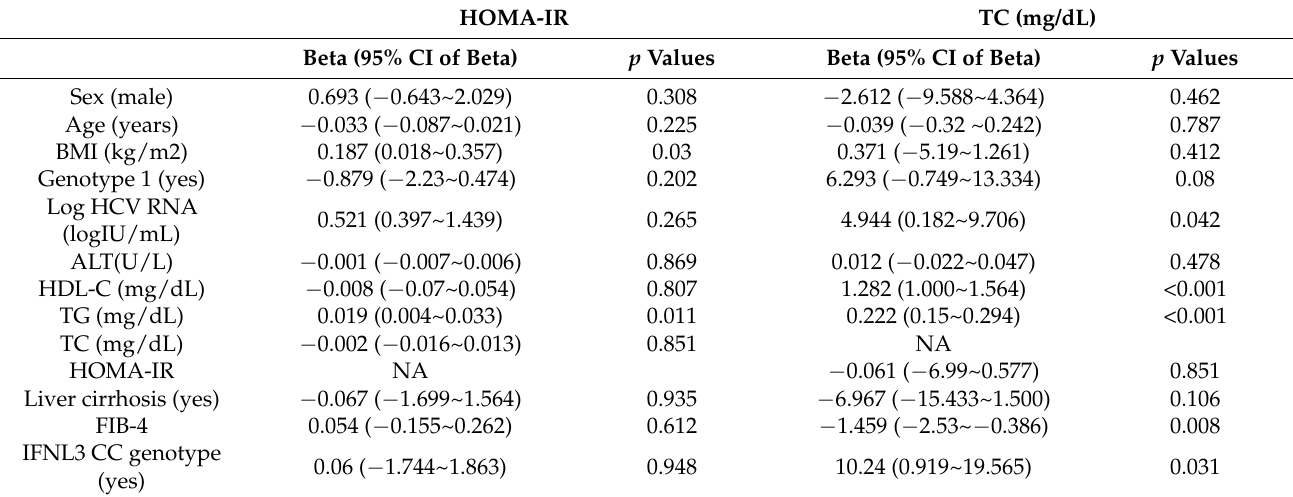
Table 2. Multivariate analyses for factors of HOMA-IR and TC levels in CHC patients at baseline.